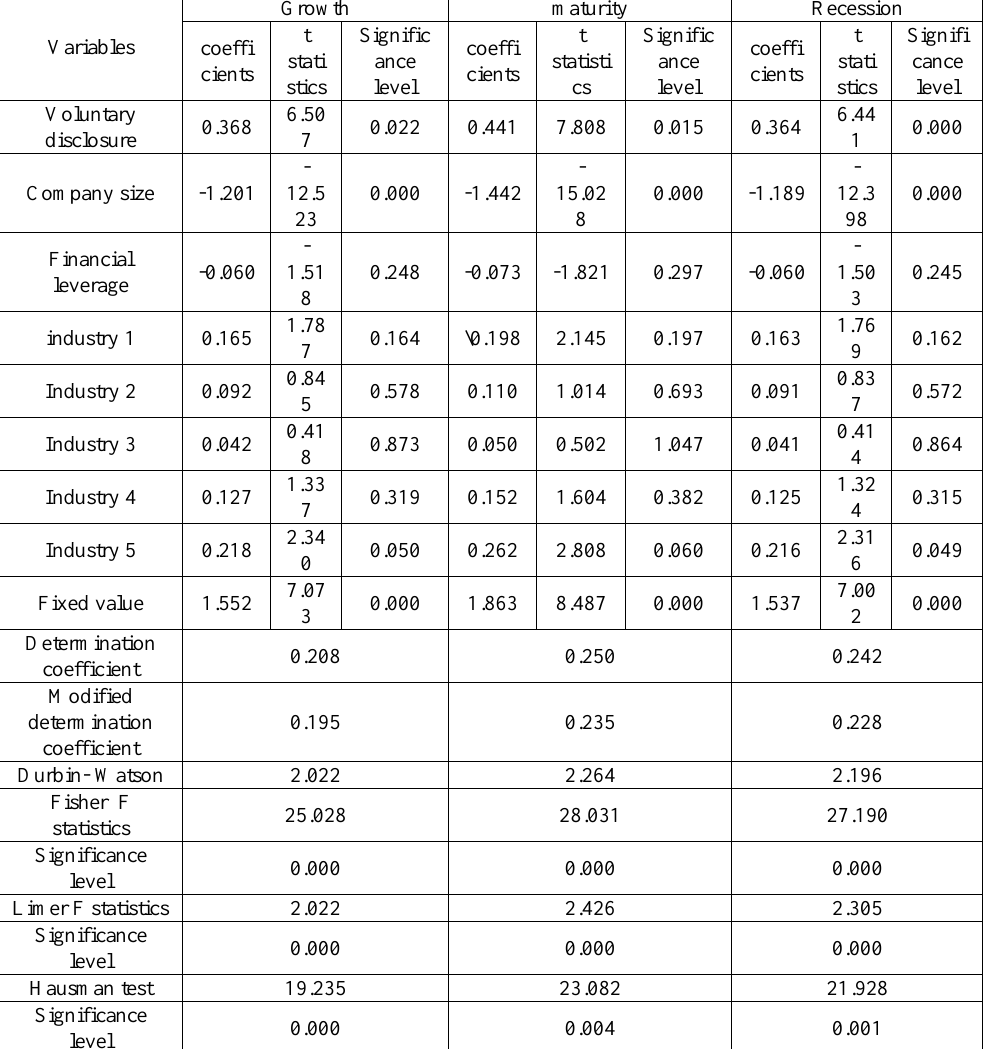
Table 4. Results of testing the relationship between voluntary disclosure and